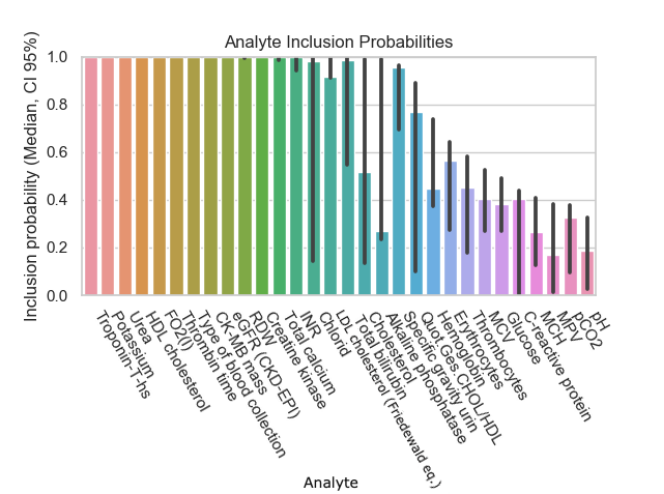
Figure 4. Inclusion probability of analytes based on a data subset with initially 80% missing